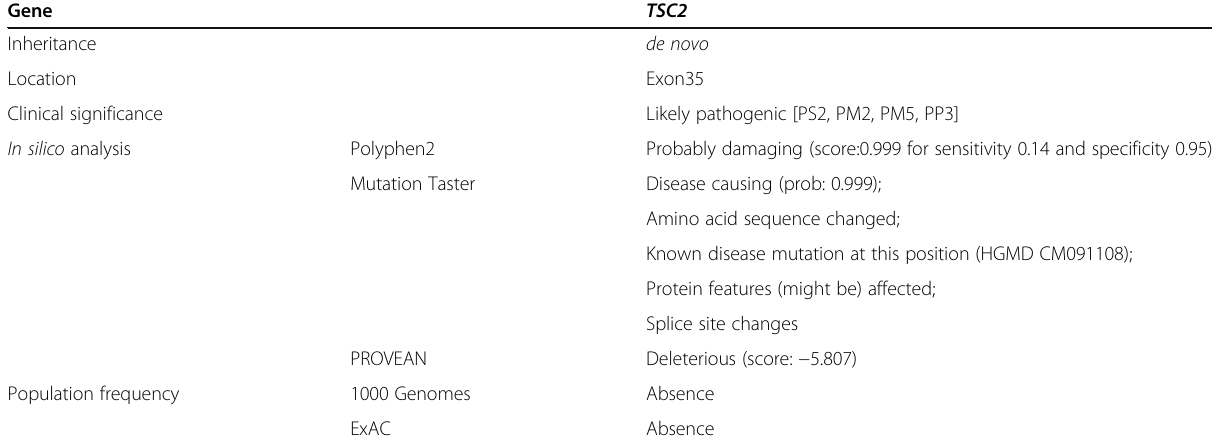
Table 1 Summary of the novel TSC2 variant